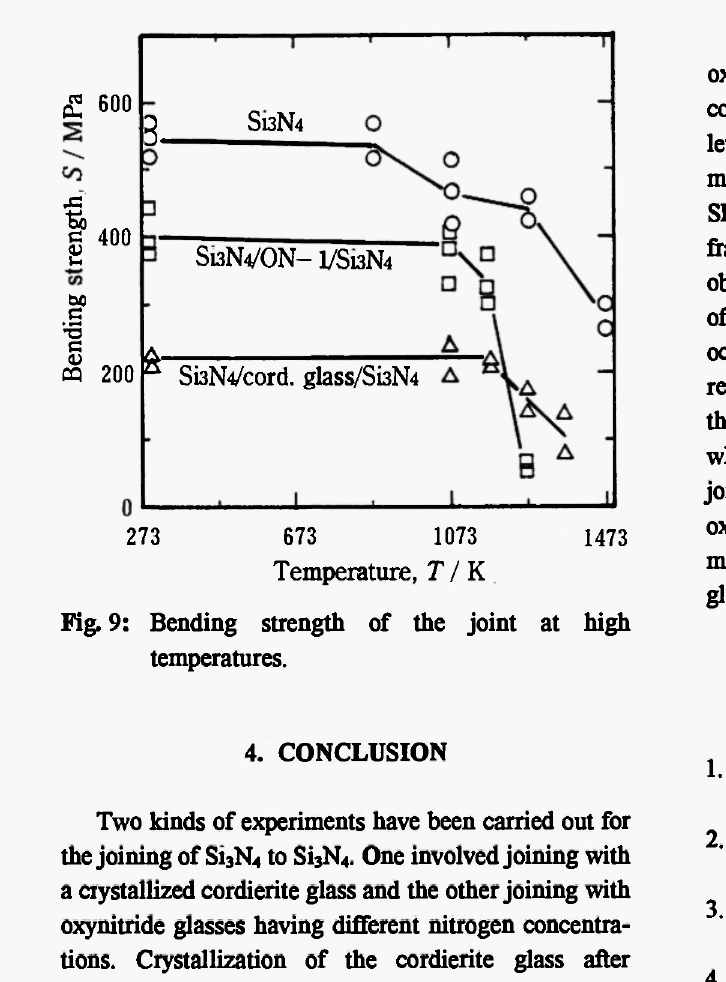
Fig. 9: Bending strength of the joint at high